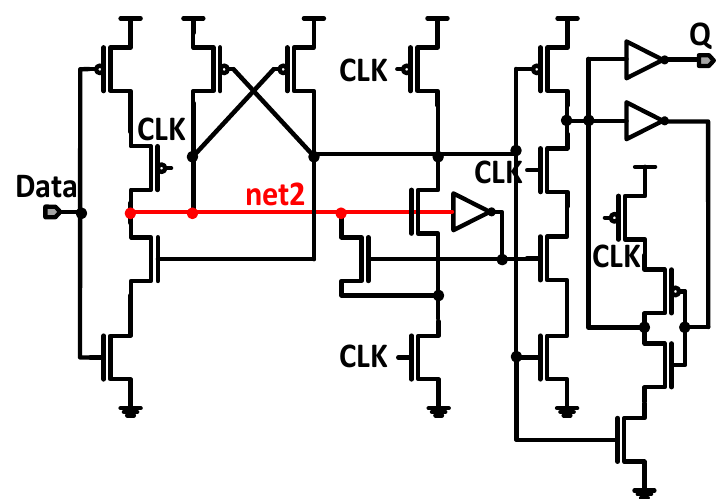
Figure 2. True Single Phase Clock Flip-Flop (TSPCFF).